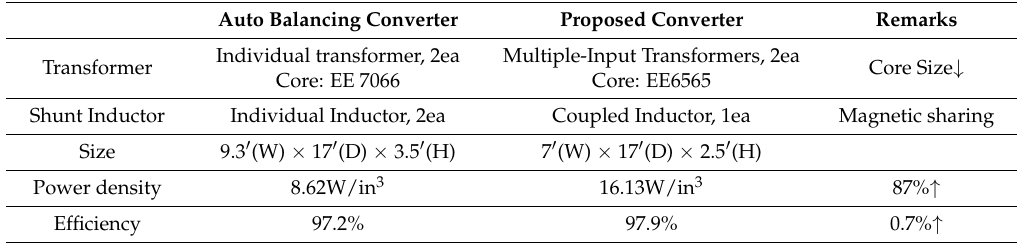
Table 5. Comparison of Proposed Converter and Automatic Balancing